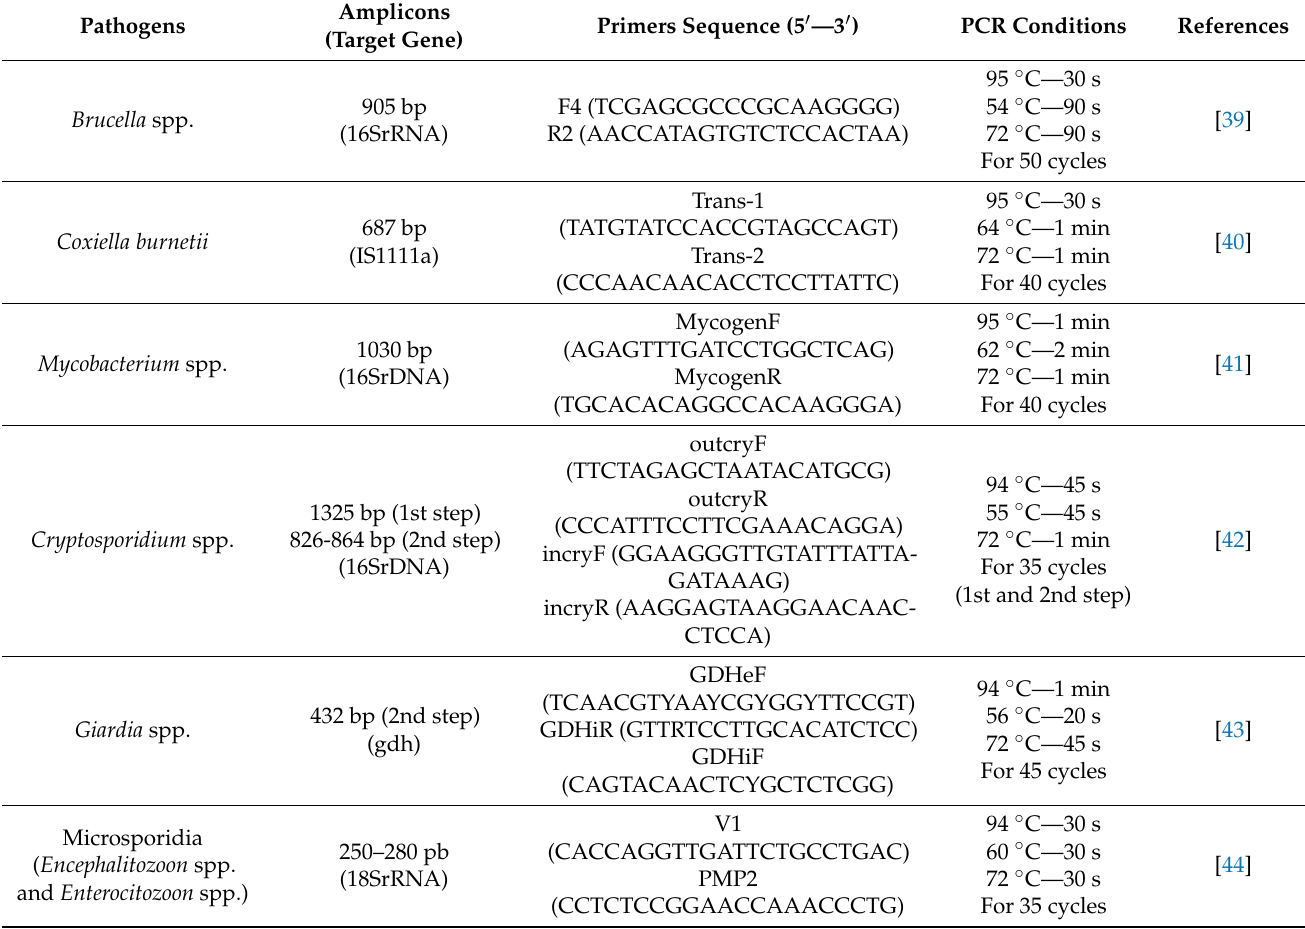
Table 1. PCR primers and conditions employed in the assays for the detection of each pathogen. The PCR conditions refers to the cycling phase which was anticipated by 5 min at 95 ◦ C and followed by 10 min at 72 ◦ C. A nested PCR was used from Cryptosporidium spp. and a semi-nested (different forward primers and same reverse) for Giardia spp.